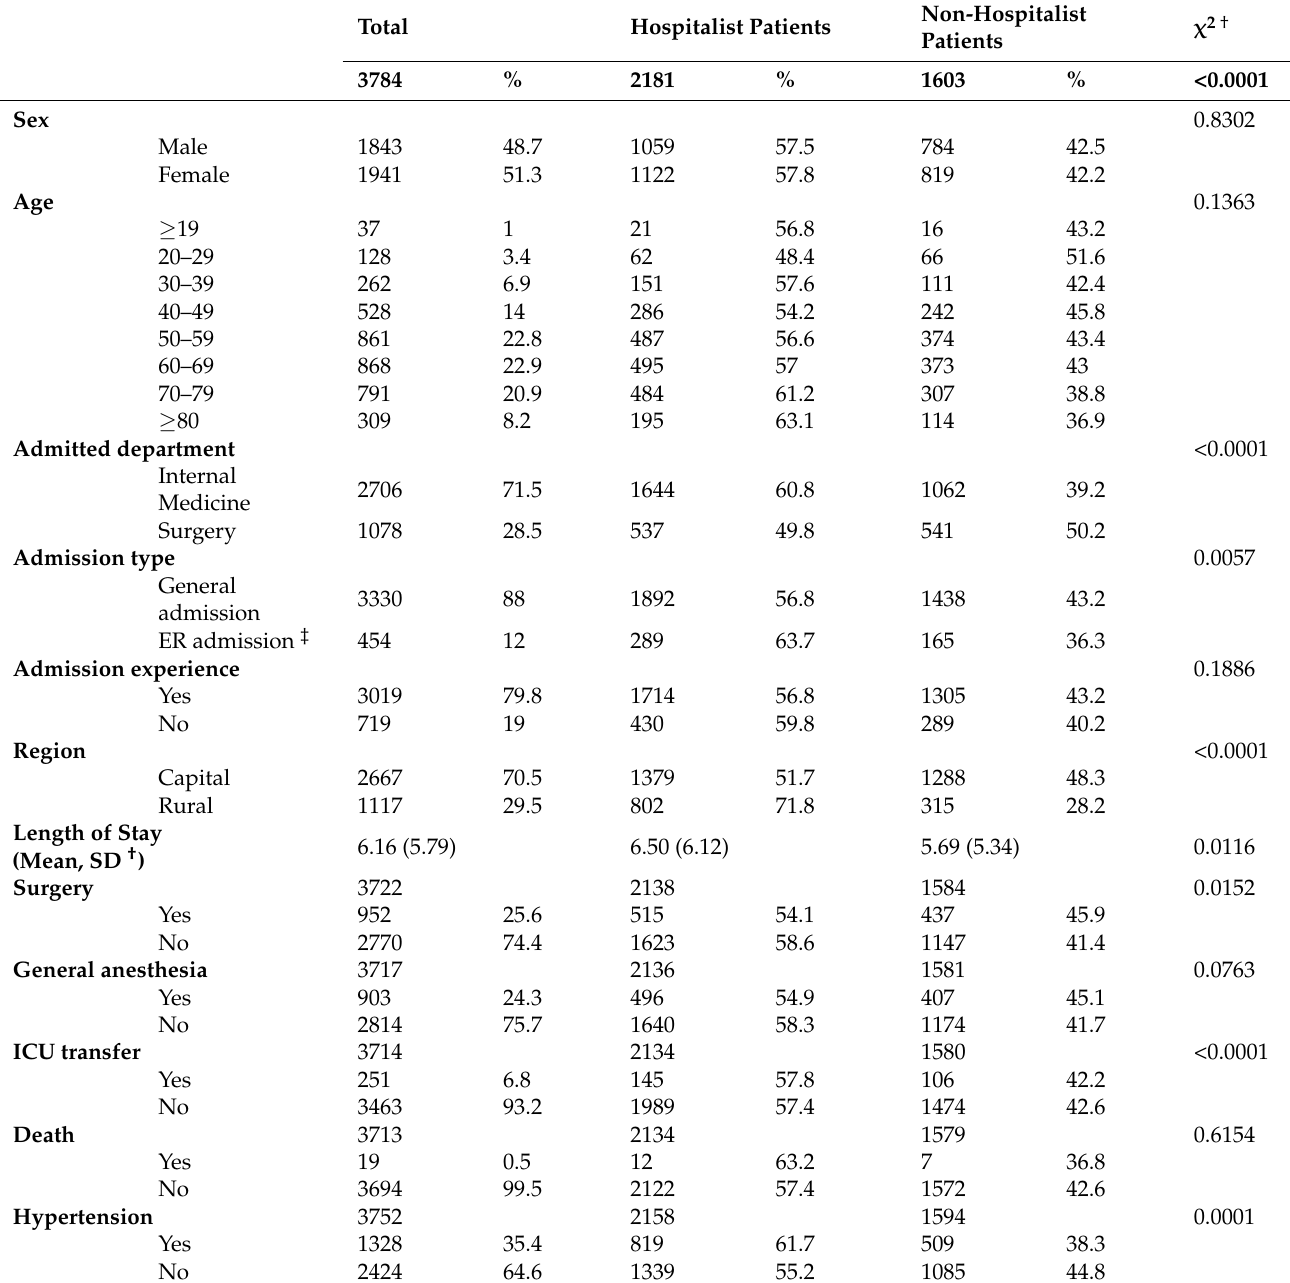
Table 1. General characteristics of the study